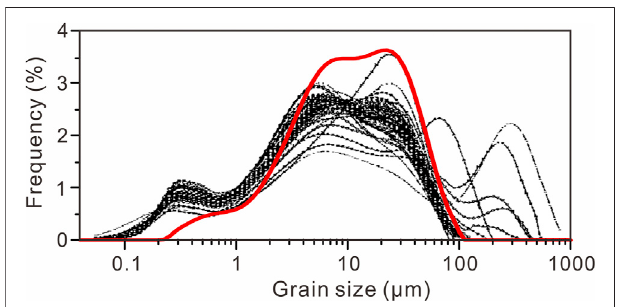
FIGURE 6 | Comparisons between GSDs of the EM1 identi fi ed in the FS18 loess (red line) and the red clay in the CLP (black lines, Cao et al.,